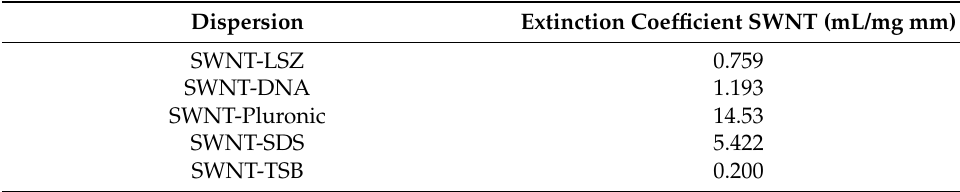
Figure 2. Example UV-Vis spectra of a serial dilution using the NanoDrop200c and resulting Beer- Lambert plots used to obtain the extinction coefficients in Table 1 and concentrations based on the Beer Lambert Law ( A = ε lc ). The initial dispersion concentrations prior to dilution were based on drying dispersions in TGA pans. ( a ) UV-vis spectra of successive dilutions of DNA-SWNT dispersions and ( b ) Beer-Lambert plot for DNA-SWNT showing the extinction coefficient corresponding to the slope. Table 1. Extinction coefficients calculated from UV-vis spectra Beer-Lambert plots.